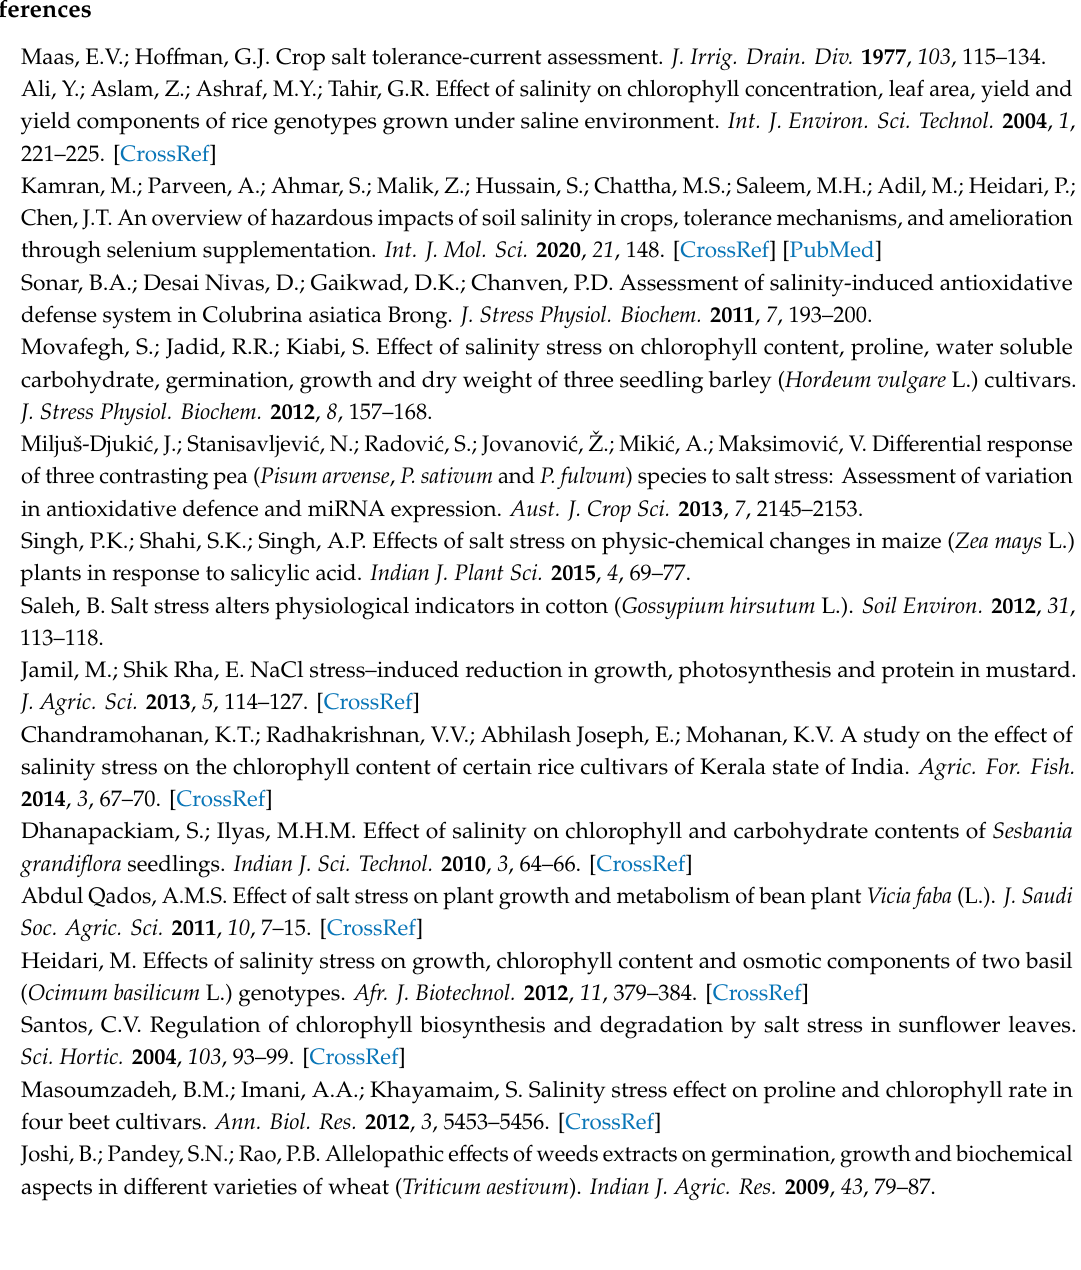
Table S1: Effect of salt stress on physiological and biochemical characteristics of Cucumis sativus and Solanum lycopersico